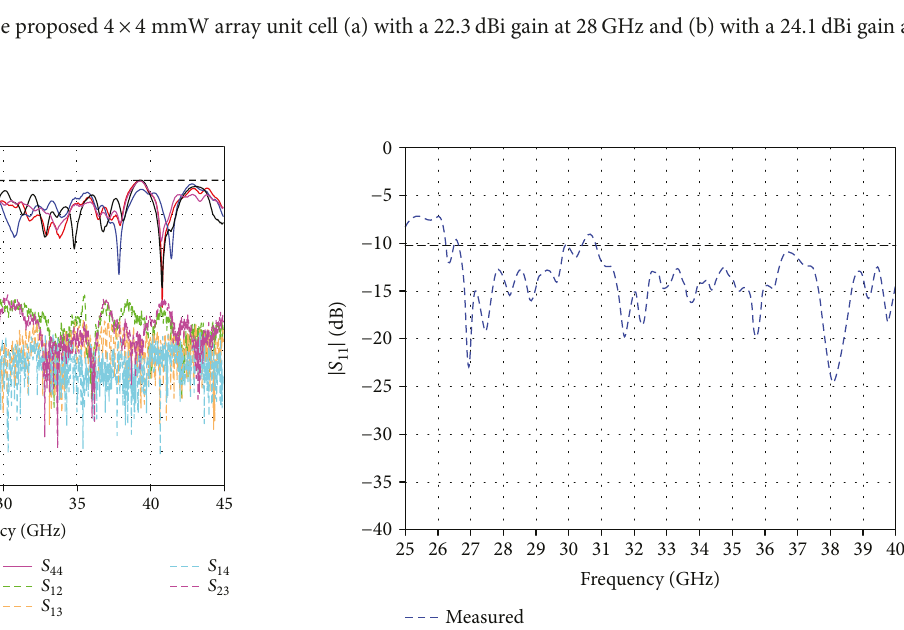
of the 4 × 4 mmW 11